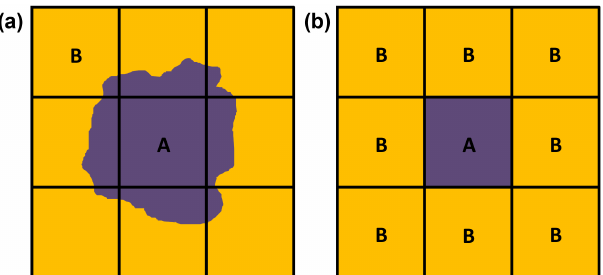
Figure 4. Raster representation. The left figure shows two hypo- thetical regions labeled A (purple) and B (yellow). The right figure shows the raster version of this geography where the dominant spa- tial region in each grid cell on the left becomes the value of the grid cell on the right. Other potential representations include mixed raster and vector (see text for description).